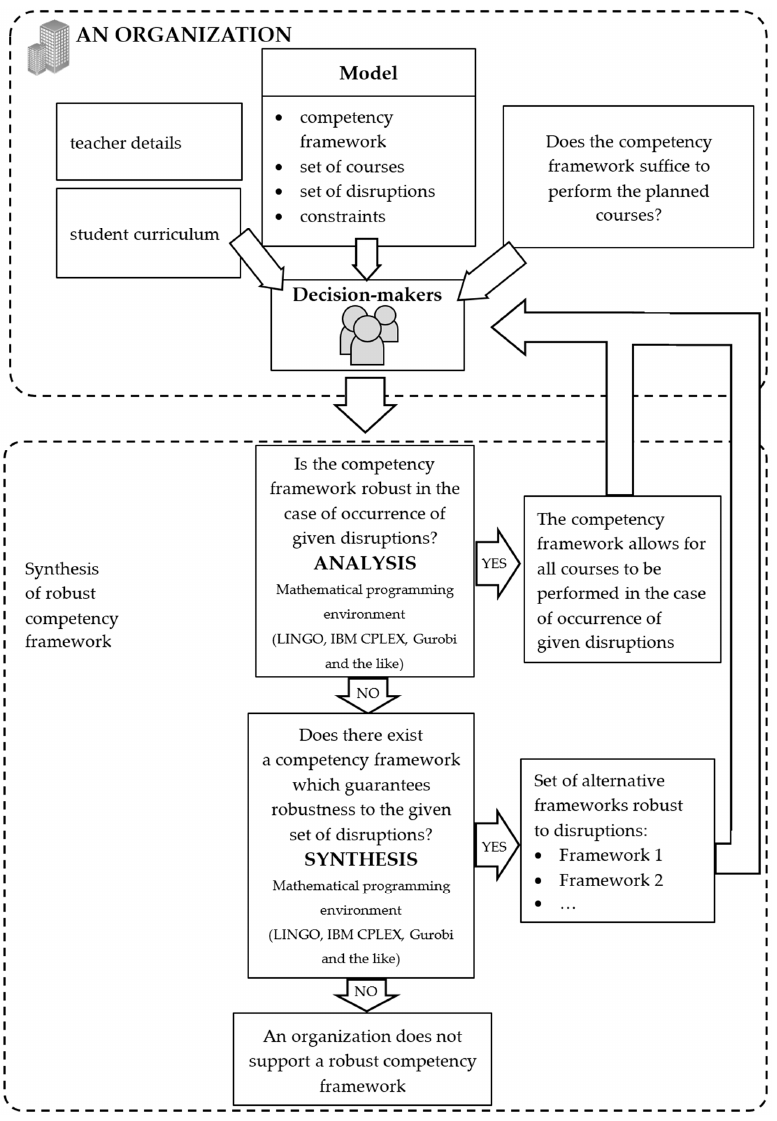
Figure 3. The synthesis method of a competency framework robust to the selected set of disruptions.